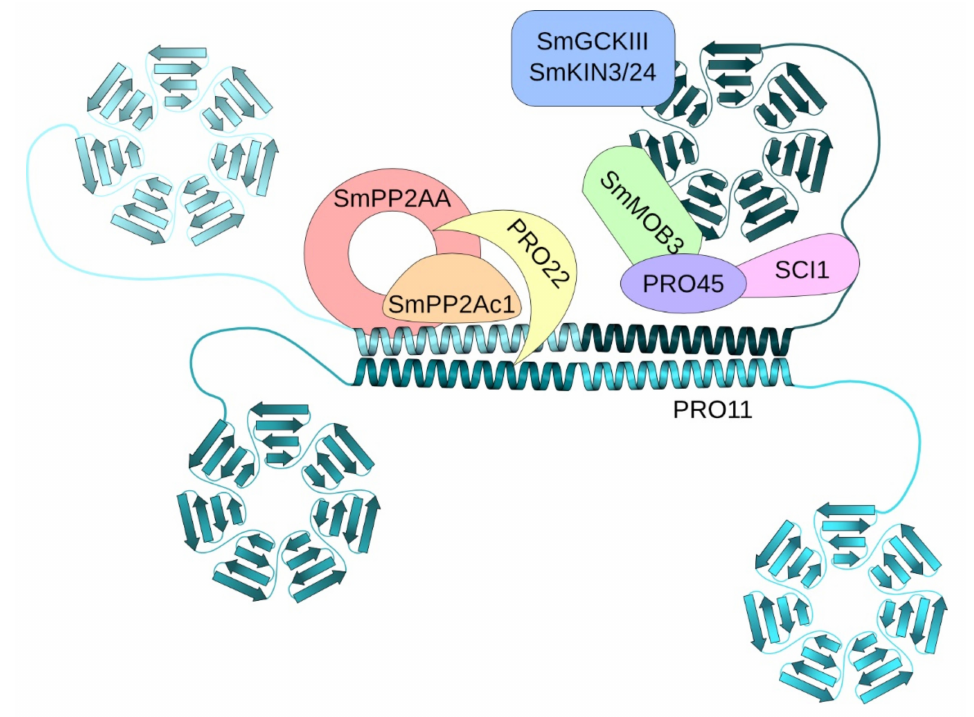
Figure 1. Schematic illustration of the SmSTRIPAK complex. According to structural data of the human STRIPAK complex [15] and data from S. macrospora [6–14], the SmSTRIPAK complex consists of a tetramer of the scaffolding human striatin homolog PRO11 harboring an N-terminal coiled-coil domain (cyan-shaded helices) and C-terminal WD40 repeats (cyan-shaded beta-propeller). Further components are the STRIP1/2 homolog PRO22 (yellow), SmMOB3 (green), the scaffolding subunit of phosphatase PP2A, SmPP2AA (red), and its catalytic subunit SmPP2Ac1 (orange) and recruited GCKIII kinases SmKIN3/24 (blue). Moreover, the SLMAP homolog PRO45 (purple) and the coiled- coil protein SCI1 (pink) are key subunits of the